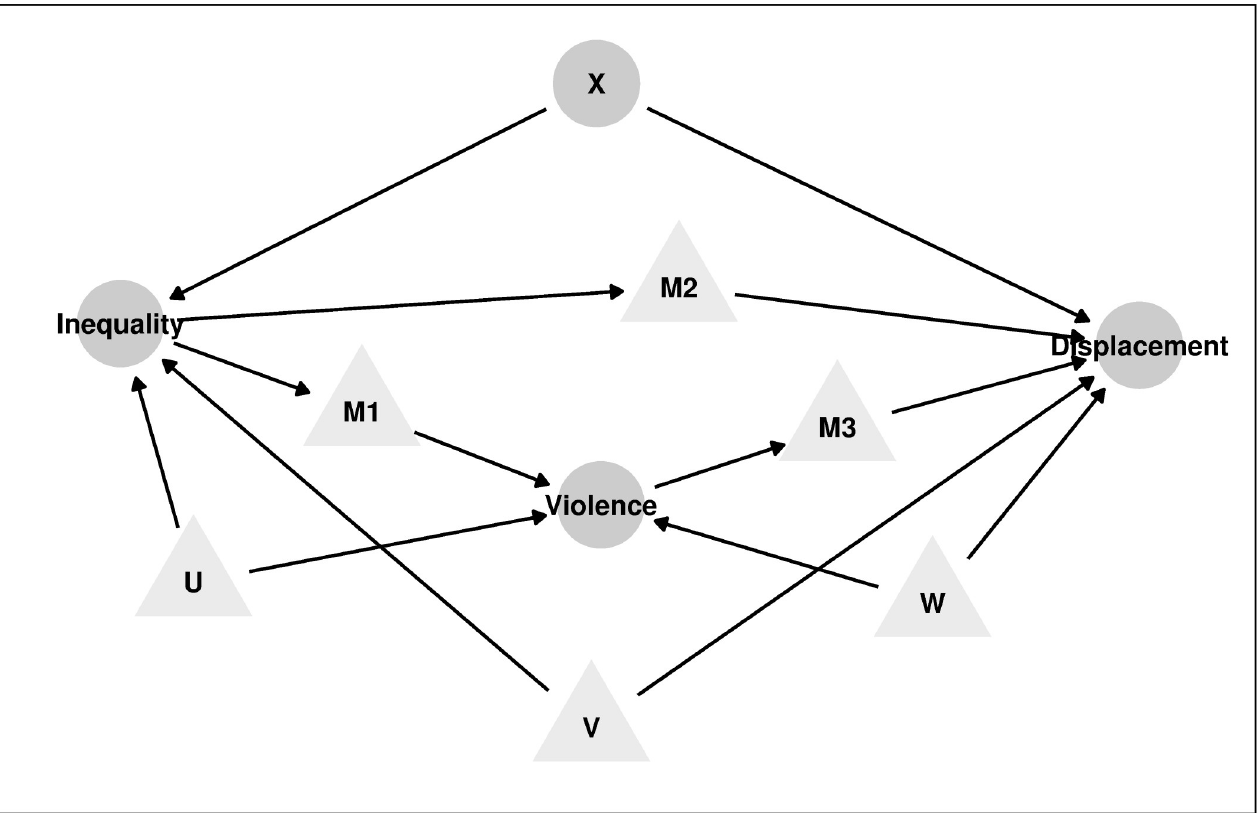
Fig 1. Directed acyclic graph of causal relationships. Round Nodes : Observed variables. Triangular Nodes : Unobserved variables. Edges : Direction of causal relationship.